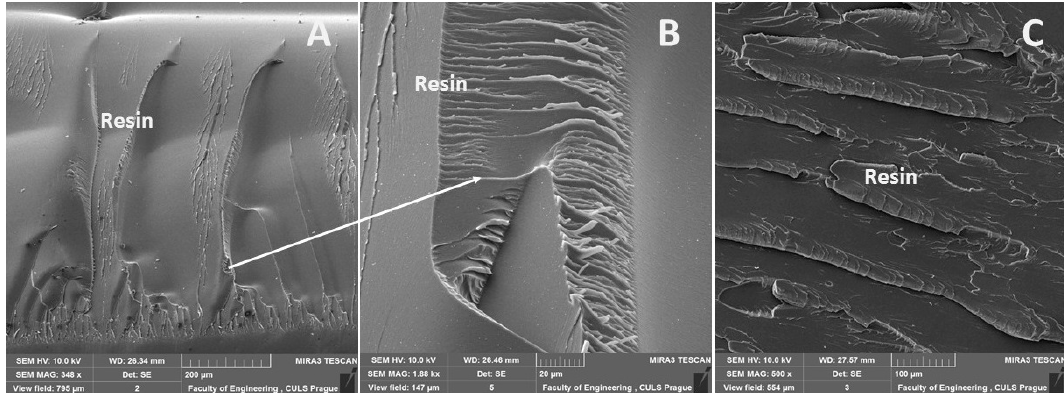
Figure 4. SEM micrographs of adhesive without filler (matrix): ( A ) brittle fracture of adhesive E5/TFF/100:26 (mag 348×), ( B ) detailed view of fracture surface of adhesive E5/TFF/100:26 (mag 1.88k×), ( C ) brittle fracture of adhesive E53/TFF/100:22 (mag 500×).